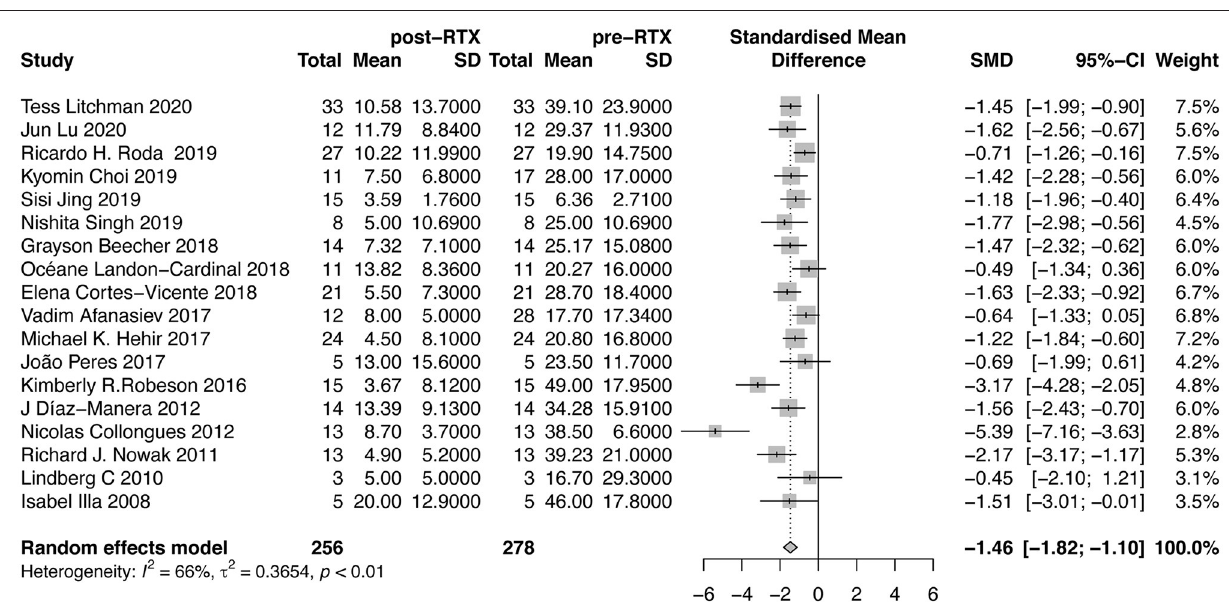
FIGURE 4 | Forest plot showing the mean effect size and 95% CI for the reduction of GC doses.